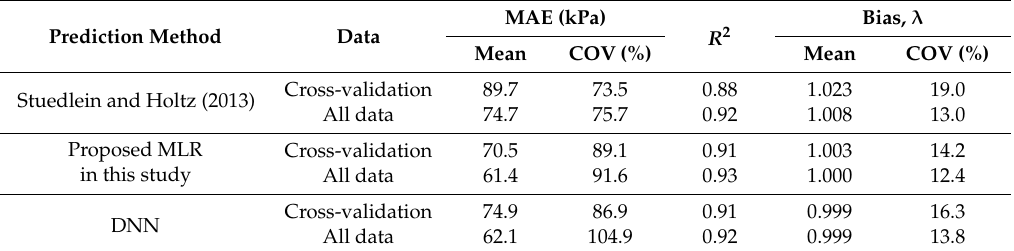
Table 6. Performance of prediction methods for ultimate bearing